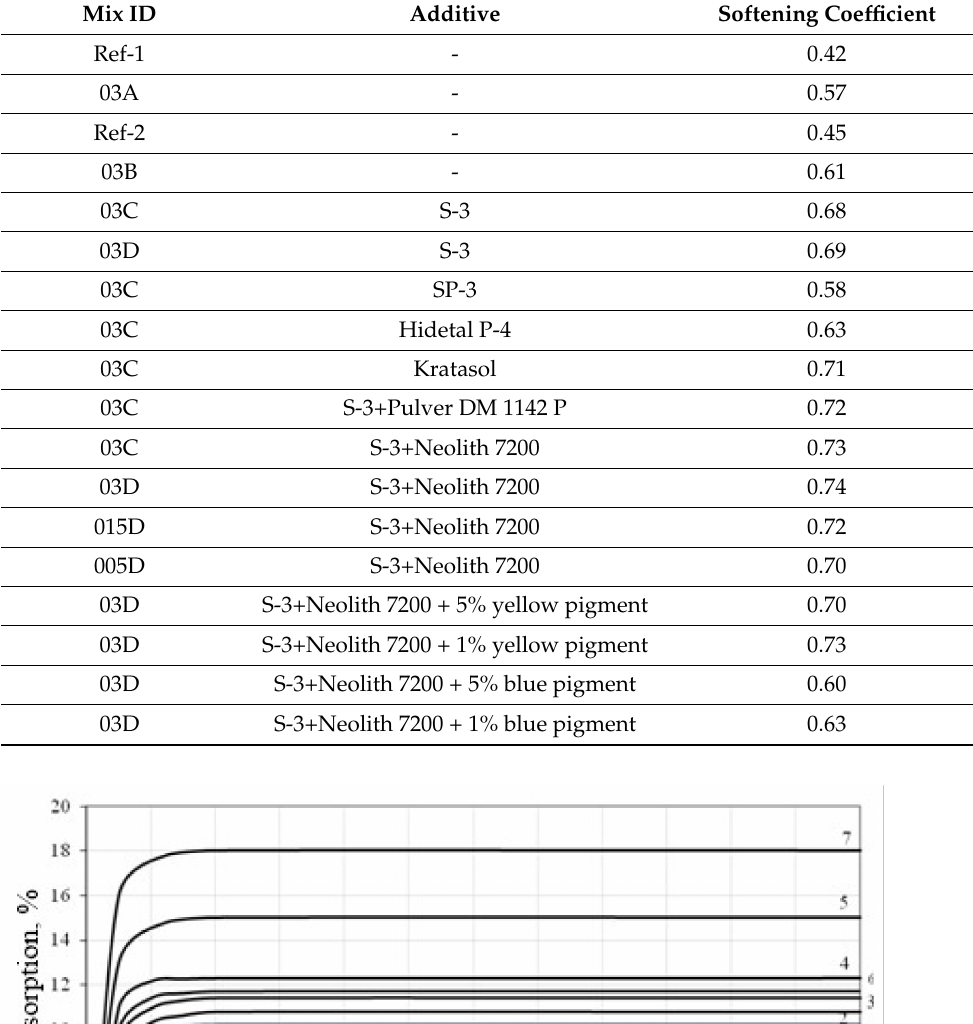
Table 14. Water resistance of the finishing coatings.